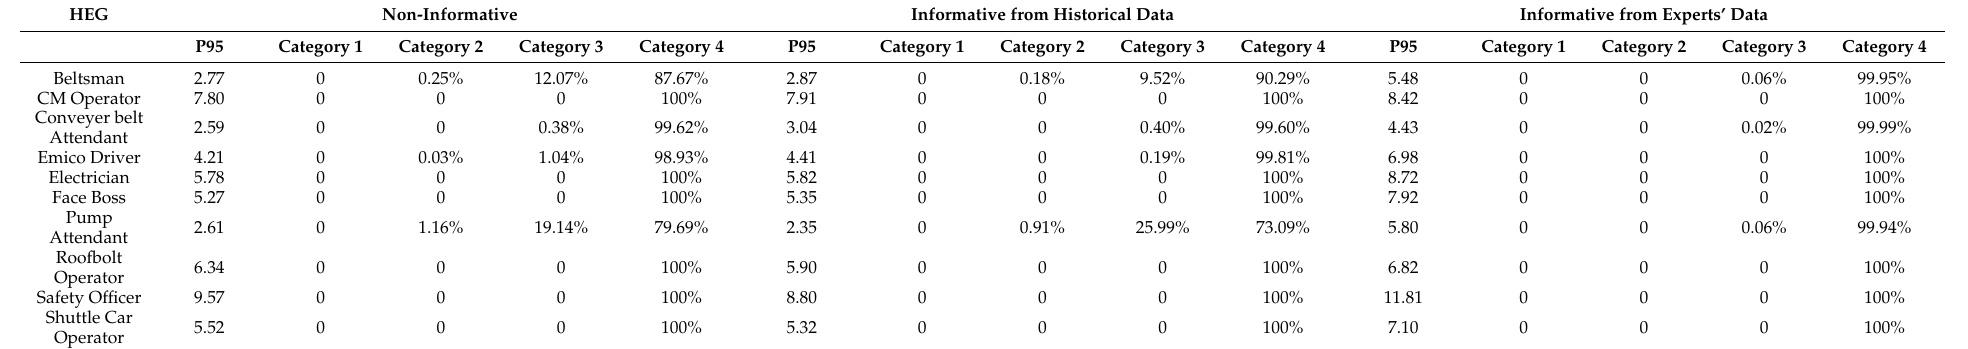
Table 3. The estimated exposure category probabilities for the posterior 95th percentile of the TWA8h dust concentration of the non-informative and informative Bayesian frameworks (OEL = 2 mg/m 3